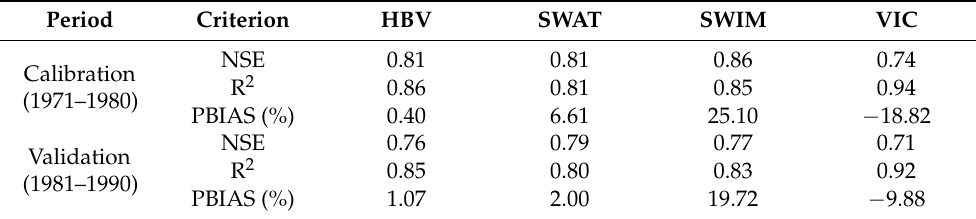
Table 2. The criteria for simulation capacity of hydrological models during calibration and validation